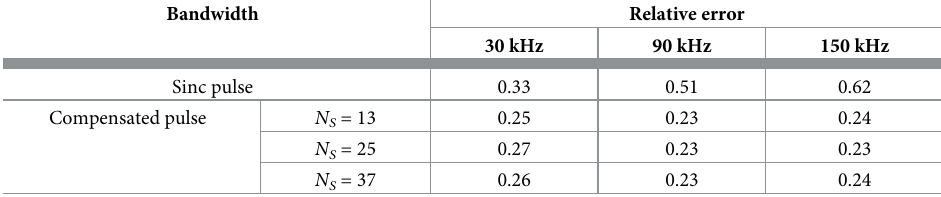
Table 2. Relative errors of the signal magnitude of the frequency